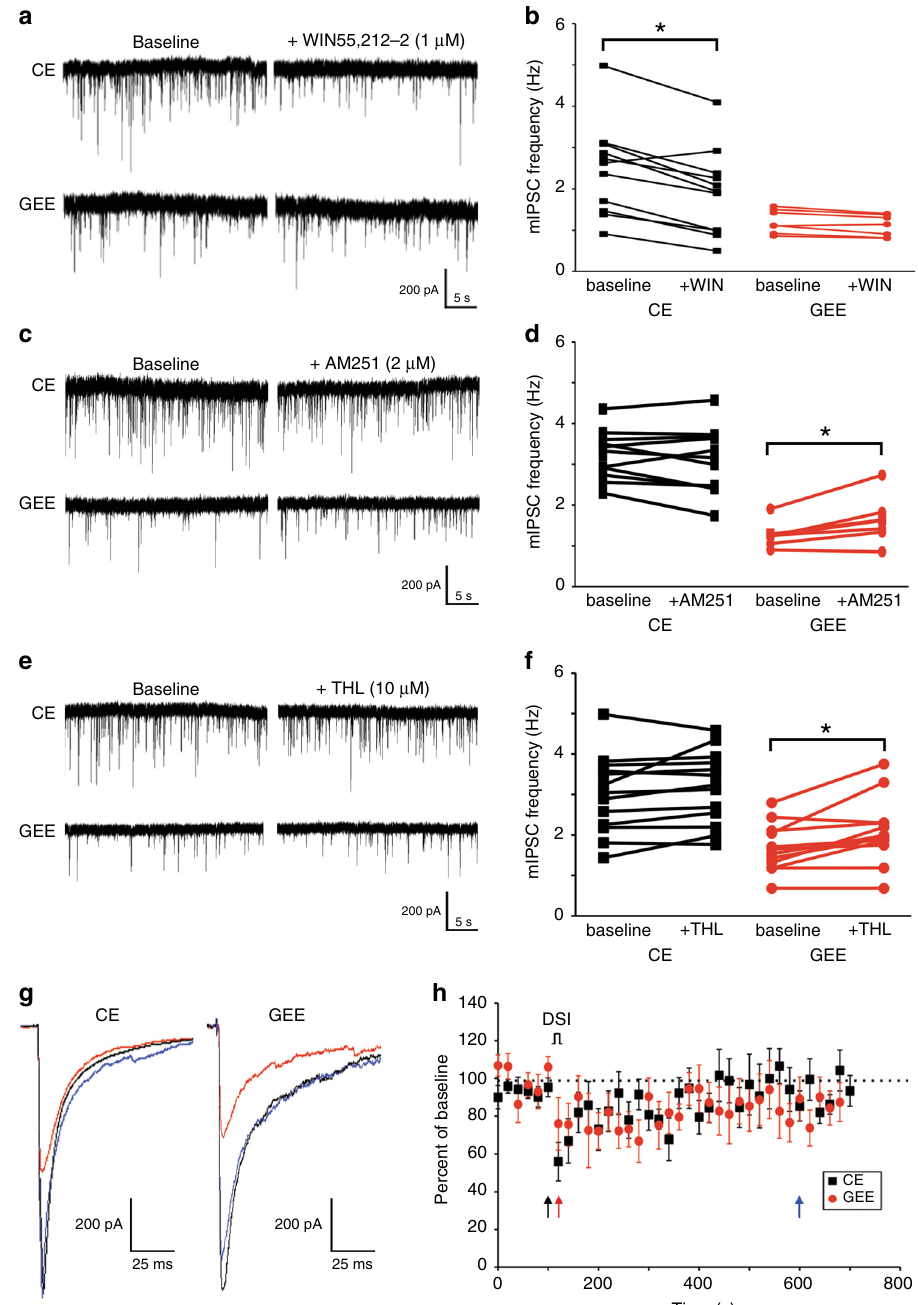
Fig. 7 GEE alters tonic endocannabinoid modulation of GABAergic transmission that can be partially rescued by decreasing the endocannabinoid tone. a Representative traces of MSNs recorded from CE and GEE before (baseline) and during exposure to WIN55-212,2, a CB1R agonist. b Graph showing WIN55-212,2 effects on frequency of mIPSCs in CE (black) and GEE (red) mouse MSNs. Note the loss of agonist effect in GEE mouse neurons. c Representative traces of MSNs recorded from CE and GEE before (baseline) and during exposure to AM251, a CB1R antagonist. d AM251 increases the frequency of mIPSCs in GEE but not CE. e Representative traces of MSNs recorded from CE and GEE before (baseline) and during exposure to tetrahydrolipstatin (THL), a DAGL inhibitor. f Graph showing THL effects on mIPSCs frequency in CE and GEE mice, with increases only observed in GEE neurons. g Representative traces of MSNs recorded from CE and GEE before (black trace), after a 4-s membrane depolarization (DSI) (red trace) and ~8 min after DSI (blue tracE). h Graph showing DSI effects on mIPSC frequency in CE and GEE mice. The black, red and blue arrows denote the time at which the corresponding colored traces in g were taken. Error bars equal ± SEM, * = Repeated measures ANOVA Bonferroni corrected p < Fig. 10a). Increasing EC tone did not signi fi cantly alter acquisi- GEE, then it might also mimic the dysfunction in habit learning. tion or rate of lever-pressing in either context, although Adult naïve mice were given systemic injections of URB597 it appeared slightly increased (repeated measures ANOVA (FAAH inhibitor), JZL184 (MAGL inhibitor), or vehicle 48 2 h (Treatment x Training day) interaction: F s < 1.65, p s > 0.05). prior to RI and RR schedule training for 6 days (Supplementary